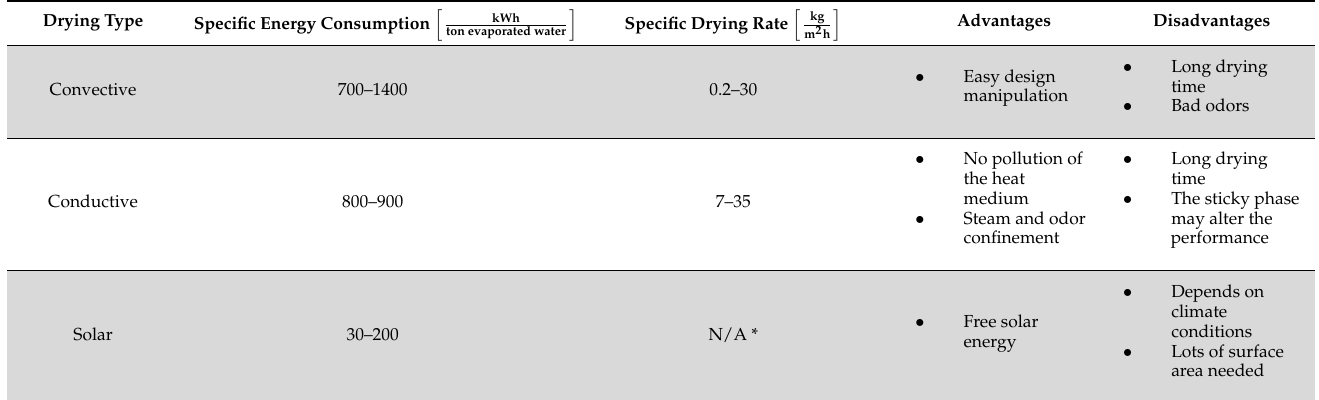
Table 1. Energy consumption and drying rates of biosolids dryer technologies. Adapted from [41].